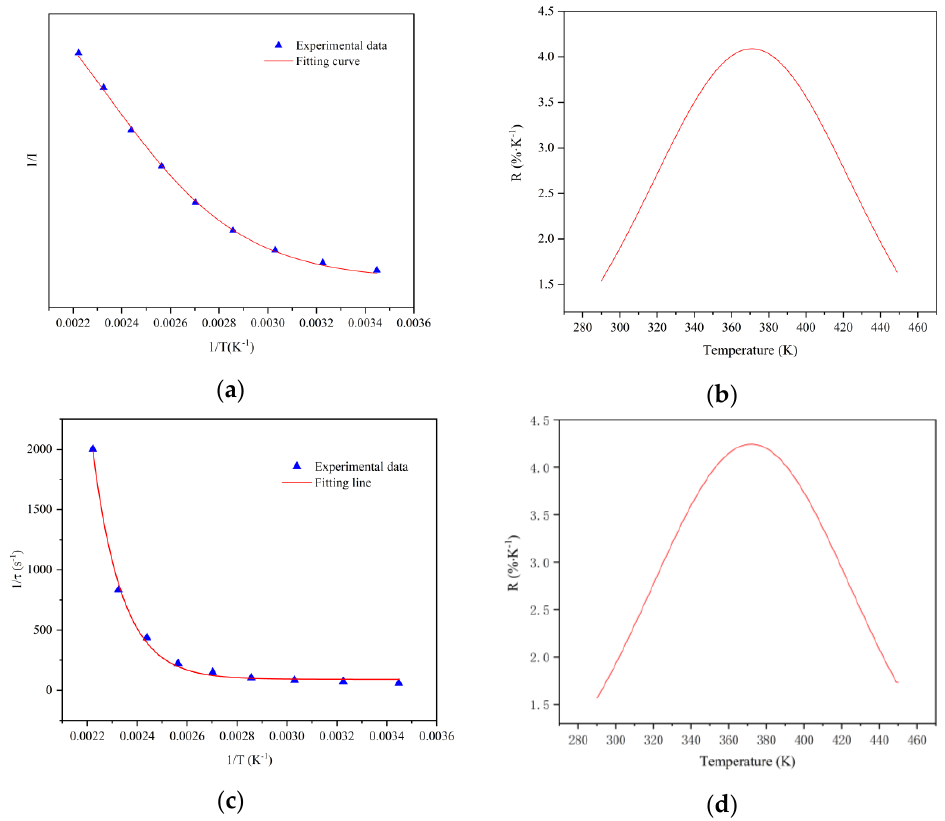
Figure 7. ( a ) The relationship between 1/I and 1/T of CSO:Mn 2+ at 290–450 K. ( b ) The relationship between relative sensitivity of fluorescence intensity and temperature. ( c ) The relationship between 1/ τ and 1/T of CSO:Mn 2+ at 290–450 K. ( d ) The relationship between relative sensitivity of fluorescence lifetime and temperature.